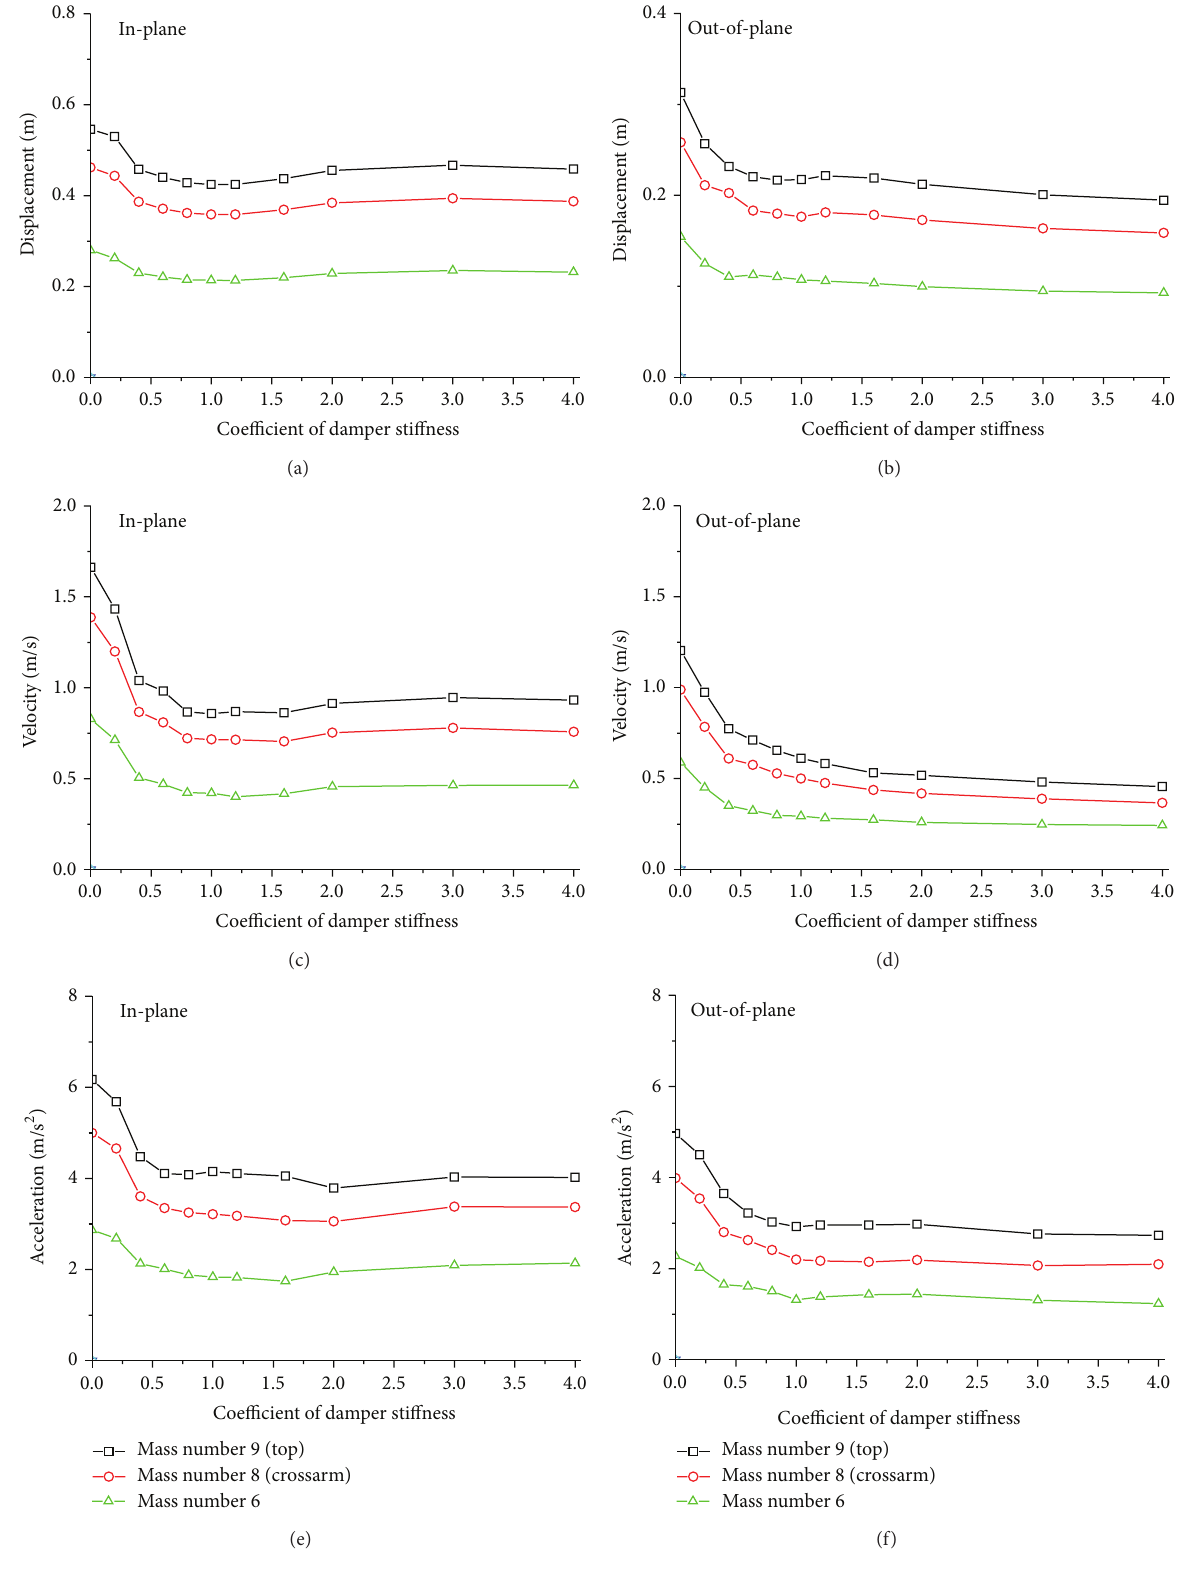
Figure 9: Variation of maximum responses with damper